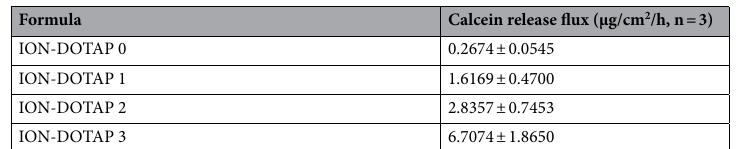
Table 1. The release flux value of calcein released from β-ionone liposomes prepared with various concentrations of added DOTAP.